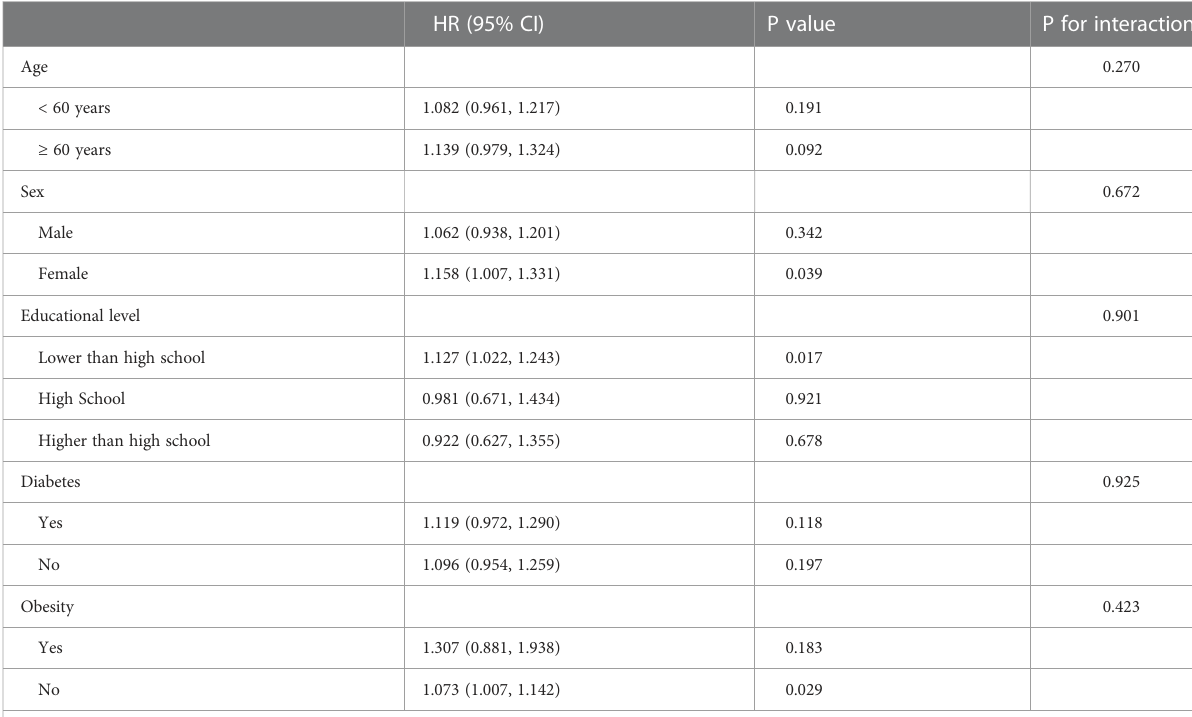
The multivariate adjusted model used in the subgroups analysis consisted of all covariates used in the multivariate adjusted models in Table 2 except for the variable (as a categorical variable) that was used for strati fi cation. The HR was examined by per 1-unit increase of HbA1c. The interaction of HbA1c and variables used for strati fi cation was examined by likelihood ratio tests. HbA1c, hemoglobin A1c; HR, hazard ratio; CI, con fi dence interval.